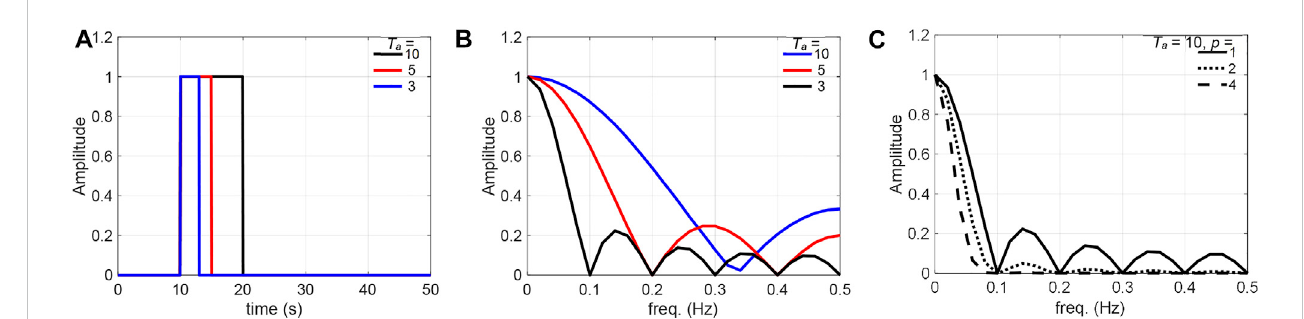
FIGURE 4 Moving average fi lters: (A) average fi lters inthe time domain, (B) frequency response function | F av ( f a )|, and (C) frequencyresponse functions | F av ( f a ) p | for the multiple-pass moving average fi lter with duration T a =